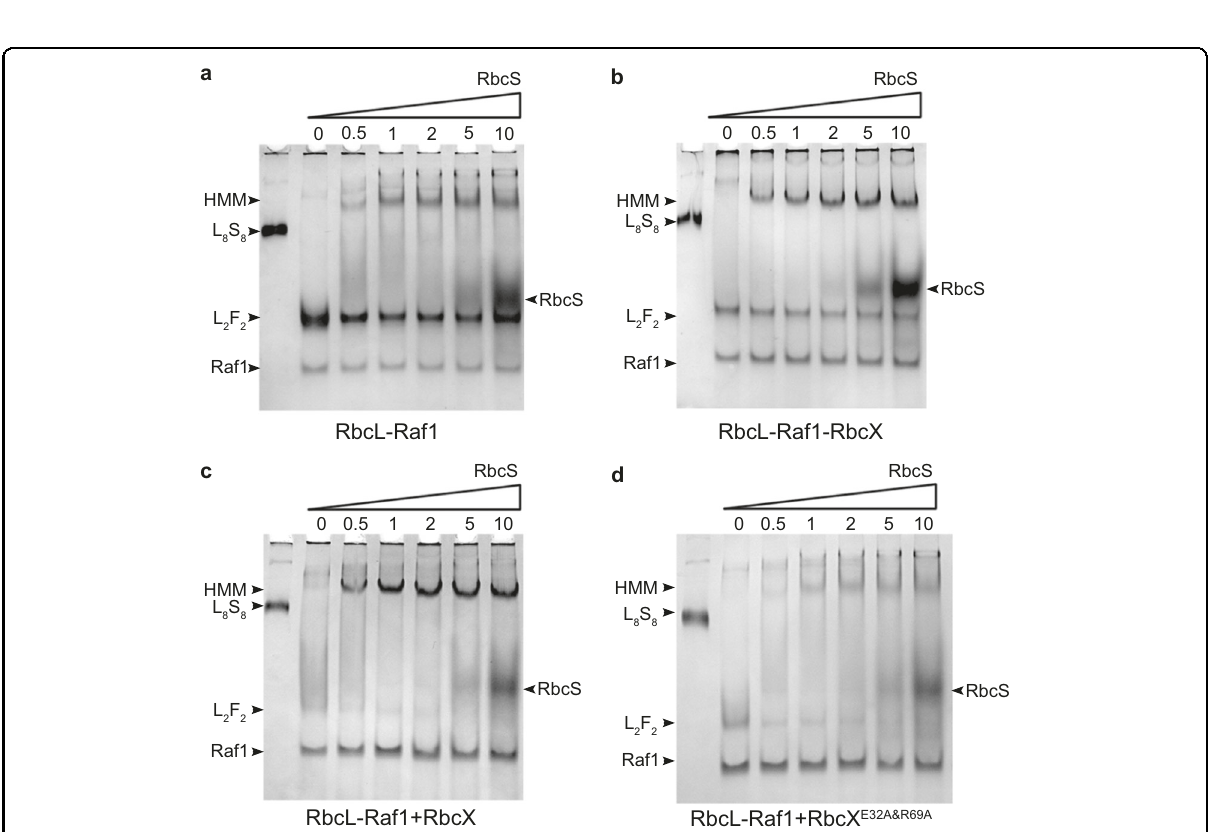
Fig. 2 Native-PAGE analyses of RuBisCO assembly. a – d RbcS proteins at increasing concentrations were added to the solution of RbcL – Raf1 ( a ), RbcL – Raf1 – RbcX ( b ), or RbcL – Raf1 pre-incubated with RbcX ( c ) or RbcX E32A&R69A ( d ). The concentrations of RbcS are 0, 2, 4, 8, 20, and 40 μ M, with the molar ratio of 0, 0.5, 1, 2, 5, and 10 fold RbcS (as shown at the top) to RbcL. The concentrations of RbcX and RbcX E32A&R69A are 8 μ M, which is 2-fold that of RbcL. The assembly intermediates are indicated by arrows on the left of the native-PAGE, in which HMM represents the complexes of high- molecular-mass intermediates. The Anabaena sp. PCC 7120 L 8 S 8 holoenzyme was used as the positive control in lane 1 of each panel.